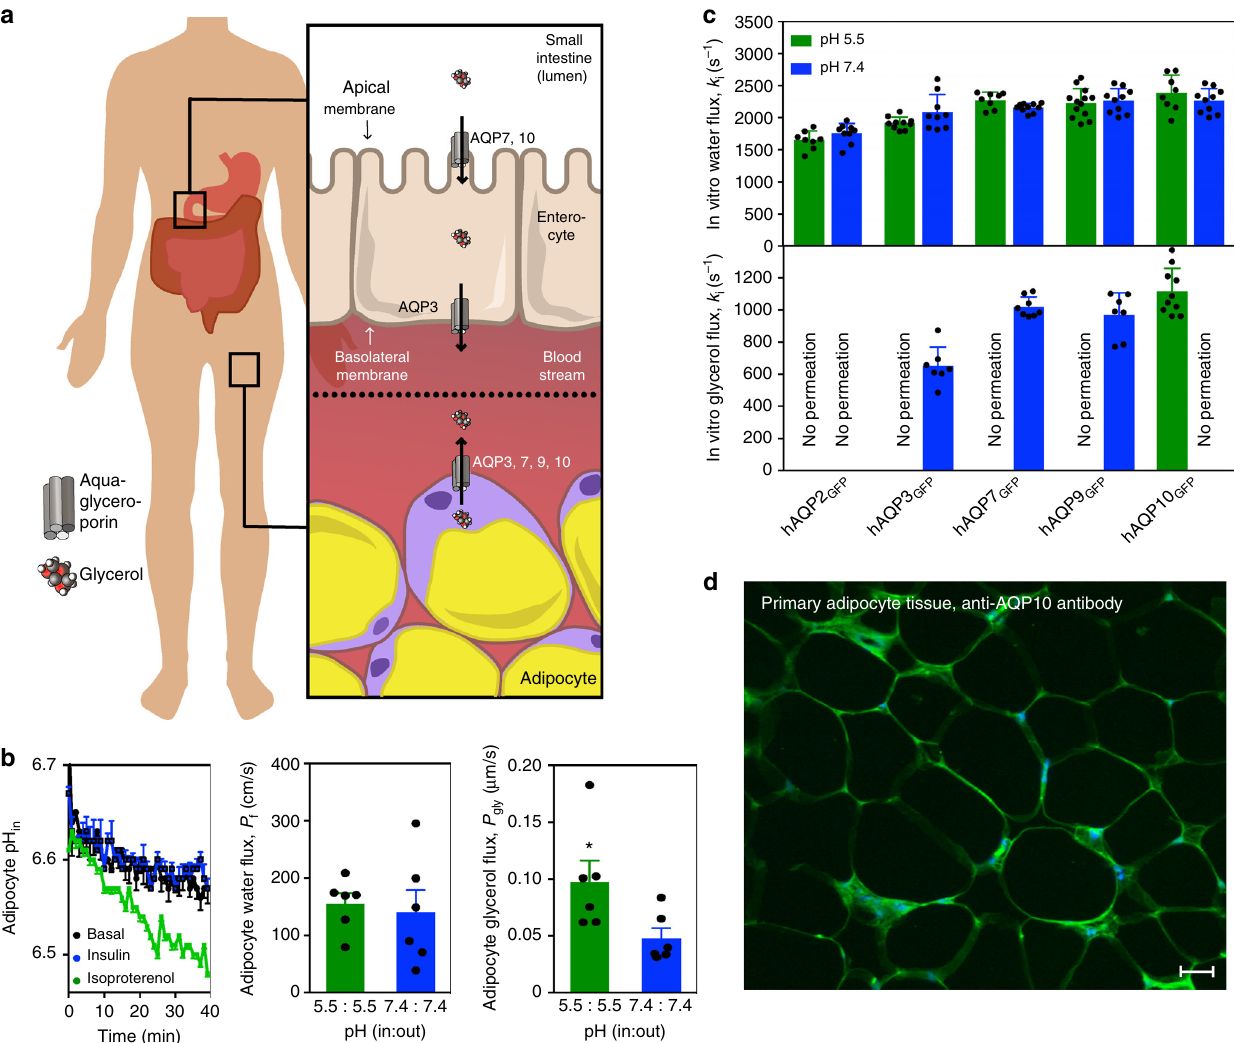
Fig. 1 Low pH stimulates human adipocyte glycerol fl ux through aquaglyceroporin AQP10. a Simpli fi ed overview of aquaglyceroporin-mediated regulation of human body glycerol homeostasis. Glycerol absorption in the small intestine (enterocytes) occurs through AQP7 and 10, and via AQP3-mediated excretion into the bloodstream, whereas release into the circulation from fat tissue (adipocytes) involves AQP3, 7, 9 and 10. b Intracellular pH changes in human adipocytes under basal (control, black), lipogenic (insulin, blue) and lipolytic (isoproterenol, green) conditions. Results are given as mean ± SEM. P < 0.001 isoproterenol vs . control and insulin (ANOVA followed by Newman – Keuls ’ s Q test; N = 3). Water and glycerol permeability of human adipocyte plasma membrane vesicles exposed to glycerol gradient. Flux was measured using identical pH inside and outside: pH 7.4 (blue) or 5.5 (green). Water (P f ) and glycerol (P gly ) permeability coef fi cients were calculated as described in Methods. Results are given as mean ± SEM. * P = 0.037 vs. 7.4:7.4 (Student ’ s t- test; N = 6). c Water and glycerol permeability of GFP-fused human aquaporins reconstituted into polymersomes. k i rate constants (s − 1 ) were obtained at pH 7.4 (blue) and pH 5.5 (green). Each bar shows mean ± SD of N = 7 – 13 measurements performed for the same proteopolymersome sample. Data for shrinking proteopolymersomes indicate lack of glycerol fl ux and are not shown. See Supplementary Table 2 for a summary of the activity. d AQP10 is membrane-localized to subcutaneous human adipose tissue used for vesicle preparation. Representative immuno fl uorescence confocal microscopy images with anti-hAQP10 antibody (green) and DAPI staining for nuclei (blue). Scale bar: 200 µ